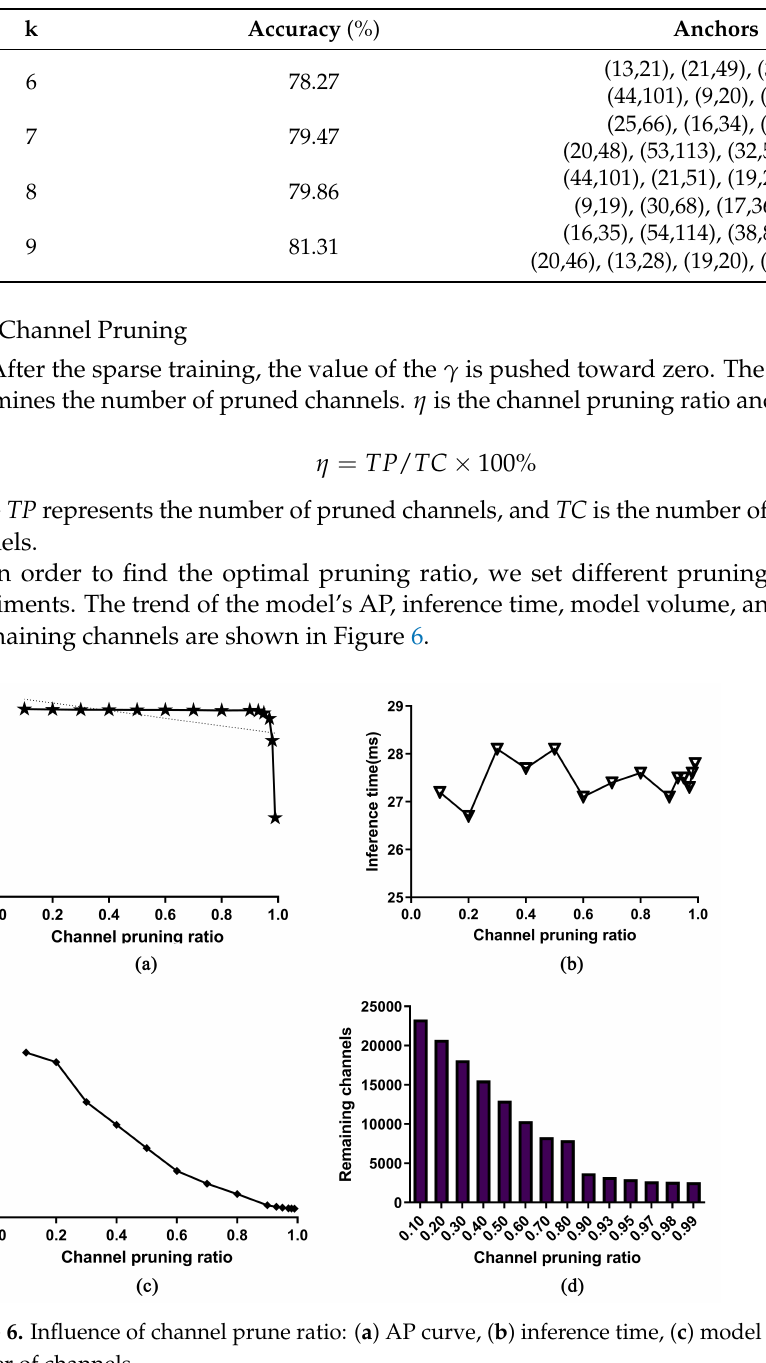
Table 2. The accuracy analysis with different K values.